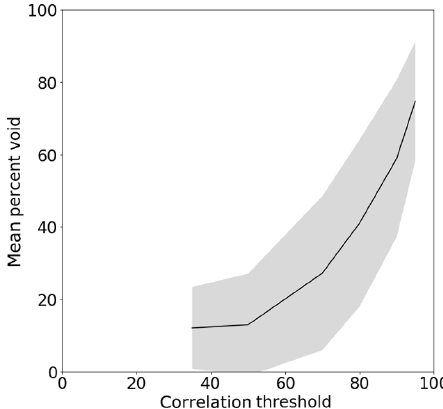
Figure 10. Mean ( ± standard deviation) percent void over glacier area for each of the correlation thresholds investigated.